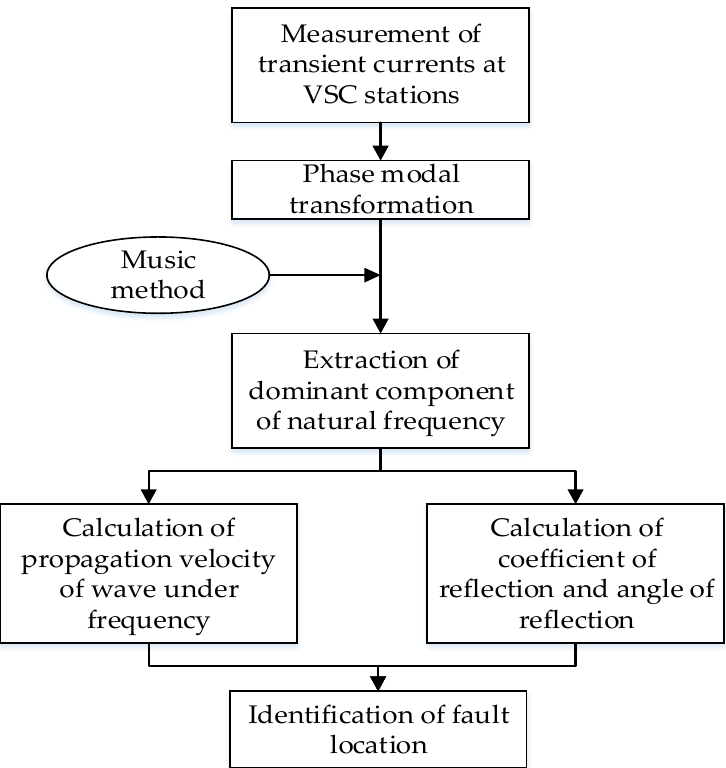
Figure 8. Flowchart of natural frequency-based protection for high-voltage direct current (HVdc) transmission lines.